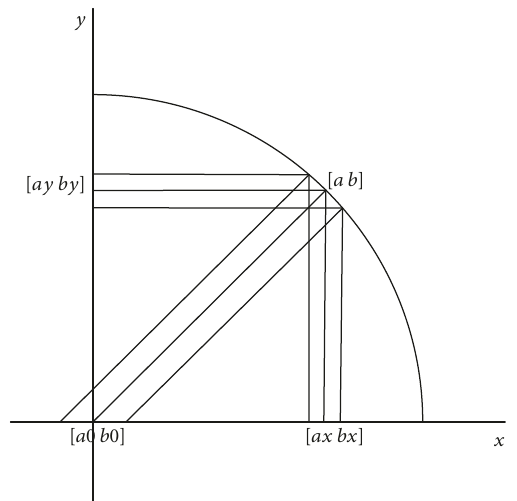
Figure 3: Coordinates of a point on the fuzzy